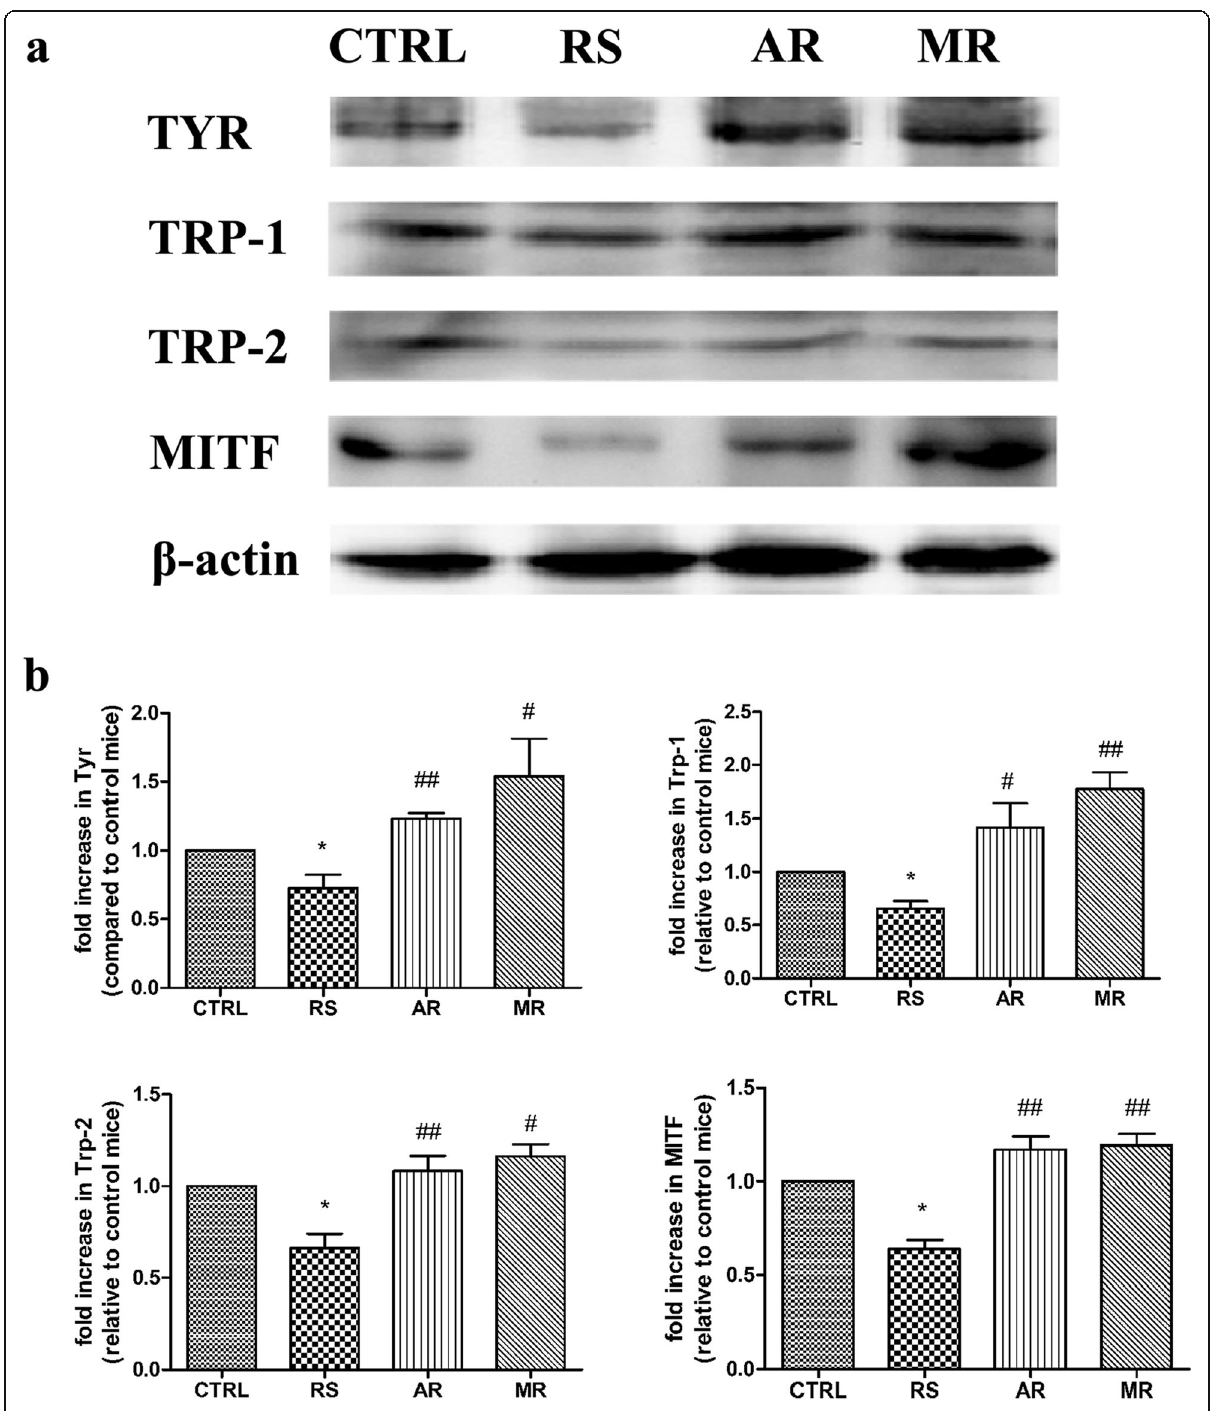
Fig. 6 AVE counteracted the inhibited effect of hair follicle growth caused by substance P in vitro. Mouse vibrissa follicles from 5-week-old male C57BL/6 mice were isolated and cultured. Each group used 10 – 15 follicles. a The length of vibrissa follicles was measured daily for 8 days. ● , the control group; ▲ , addition of 10 − 8 mol/L SP; ■ , addition of 10 − 8 mol/L SP and 10 μ g/ml AVE. * p < 0.05 compared with control group; # p < 0.05 compared with SP group. b Western blot analysis was used to examine the expression of NK-1R in murine vibrissa follicles. Equal protein loadings were confirmed using β -actin antibody. Densitometric scanning of band intensities obtained from three separate experiments by the Quantity One 1D analysis software program was used to quantify the change of proteins expressions (control value taken as onefold in each case). The data showed the mean ± S.E.M of three experiments. * p < 0.05 compared with control group; ## p < 0.01 compared with SP